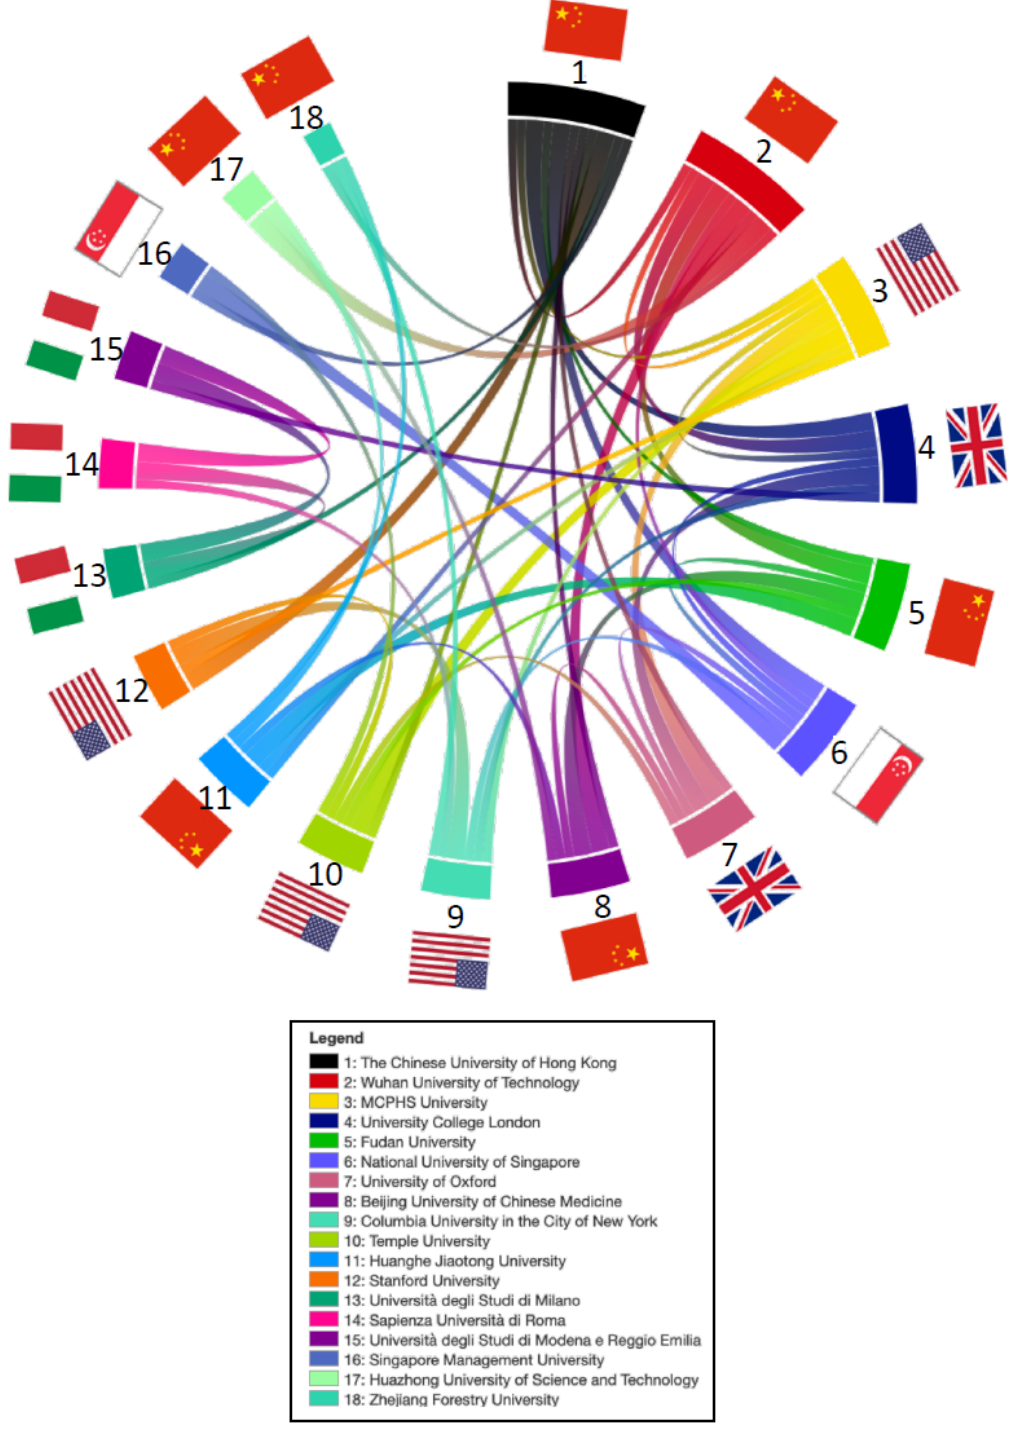
Figure 4. COVID-19 research collaboration according to institutions. Each edge connects 2 institutions that share a publication. The flags in the middle represent the countries where the institutions are located. MCPHS: Massachusetts College of Pharmacy and Health